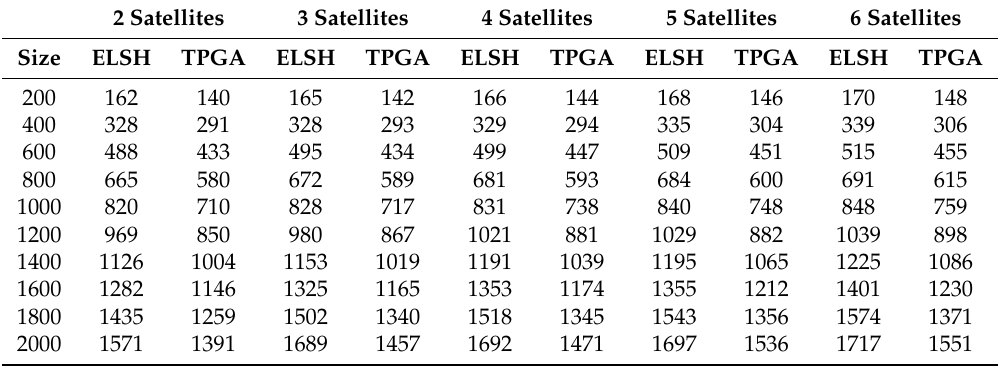
Table 5. Comparison with TPGA on the observed target number on world distribution instances.